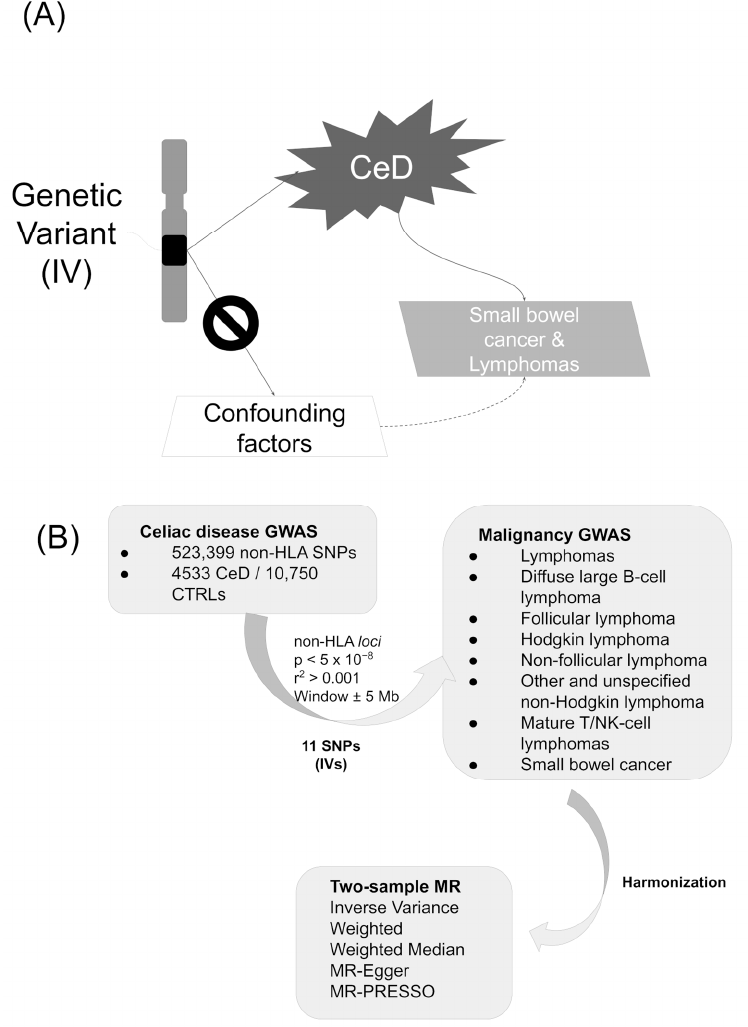
Figure 2. ( A ) Conceptual approach and ( B ) study design.